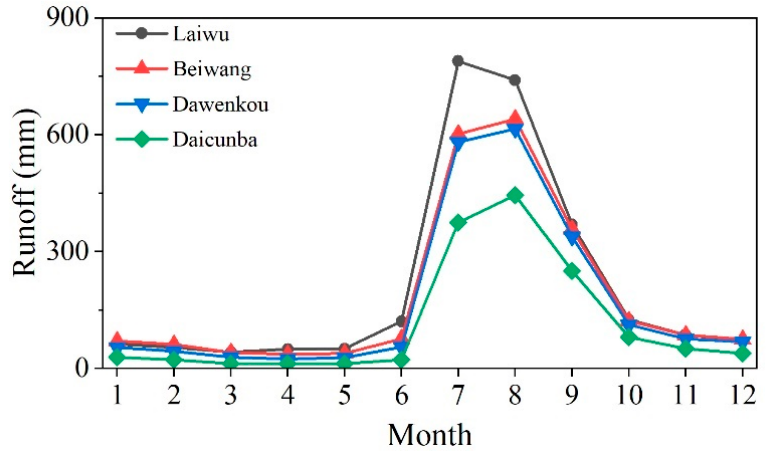
Figure 3. The annual distribution of the runoff in the Dawen River Basin.